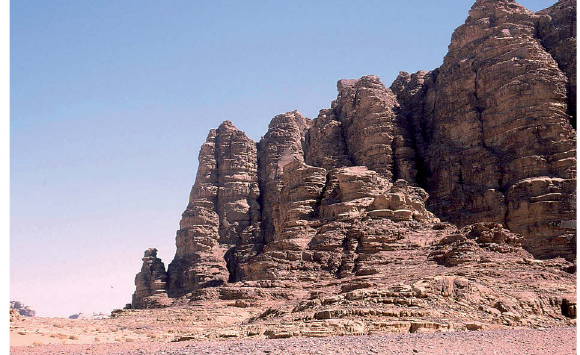
Fig. 2a. Example of sandstone rock slopes in south-west Jordan: angular rock slopes in the Umm ‘Ishrin sandstone, the northern sector of Wadi Rum area